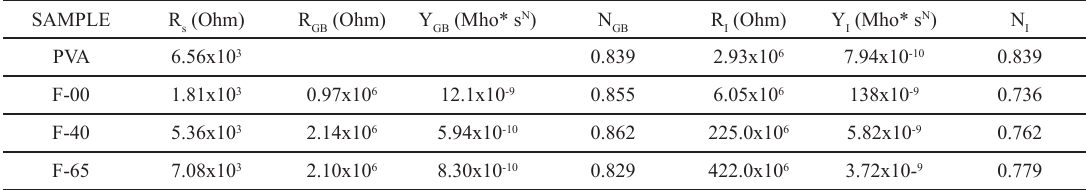
Table 3. Fitting parameters obtained from EIS analysis for the model given by Equation 2 and Equation 3 for different AgNP loaded PVA films evaluated. SAMPLE